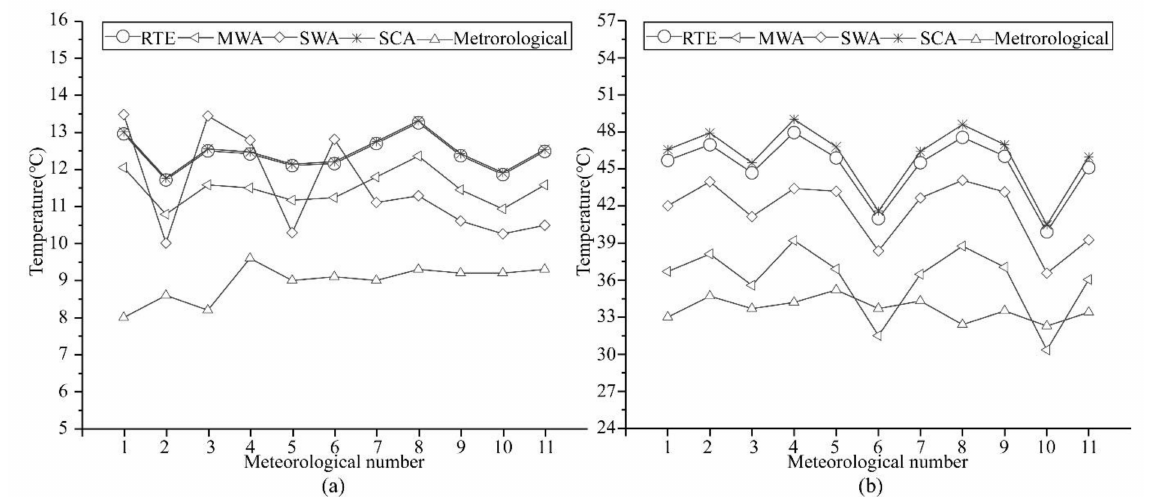
Figure 6. Comparison of local meteorological data with the retrieval results of four algorithms. ( a ) are the LST retrieval results compared with meteorological stations data on 21 January 2020; ( b ) are the LST retrieval results compared with meteorological stations data on 16 August